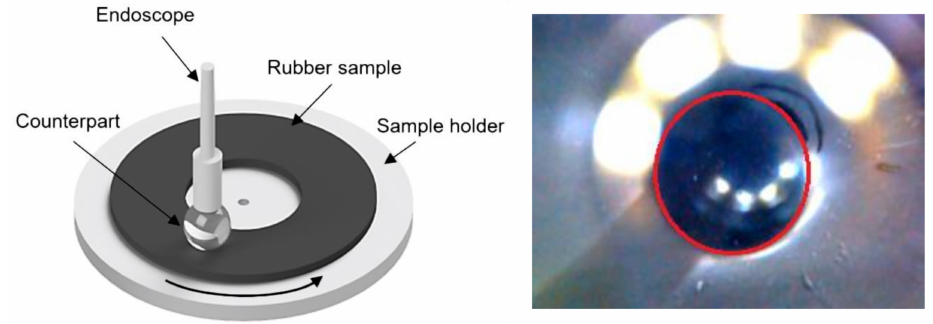
Figure 1. ( Left ) Experimental setup for measuring wear behavior of rubber samples. An endoscopic camera was used to detect changes in the contact area due to material wear. ( Right ) Sample image acquired with the setup. The dark sphere in the center is the contact area (marked with a red circle). It can be seen that multiple reflections are present, increasing the di ffi culty for contact area